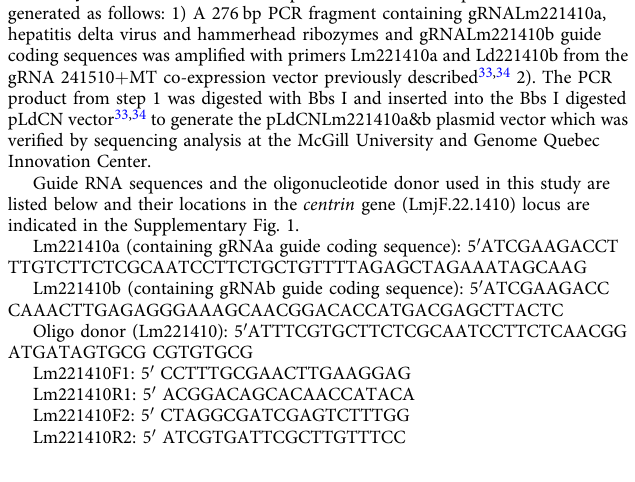
Fig. 6 Immunization or leishmanization confer comparable host protection against L. major WT infection. a Schematic representation of the experimental approach. b Gating strategies and multiparameter fl ow-cytometry based analysis for cytokine secreting T cells from pooled ears of naïve, healed and LmCen − / − immunized group of mice. c Multiparameter analysis for multiple cytokine secreting Live CD3 + CD4 + CD44 + T cells after 20 h of in- vitro re-stimulation with freeze-thaw L. major antigen ( LmFT Ag) from pooled ears (2 ears) of naïve control ( n = 2), healed ( n = 3) and LmCen − / − immunized ( n = 3) group of mice plus naive splenic APCs. Results (mean ± SEM) are representative of one experiment. Statistical analysis done by Mann – Whitney two-tailed test ( ns p − 0.9). d Pie charts analysis of the cytokine pro fi le of Live CD3 + CD4 + CD44 + T cells. e Gating strategies and